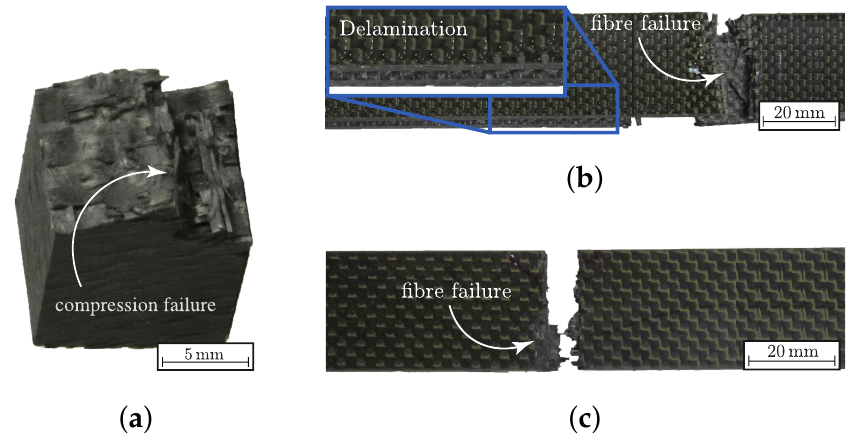
Figure 6. Phenomenological failure modes for different load paths: ( a ) compression failure ( σ c -testing [54]), ( b ) tension failure and ( c ) delamination failure ( b , c ): σ t w -testing 3